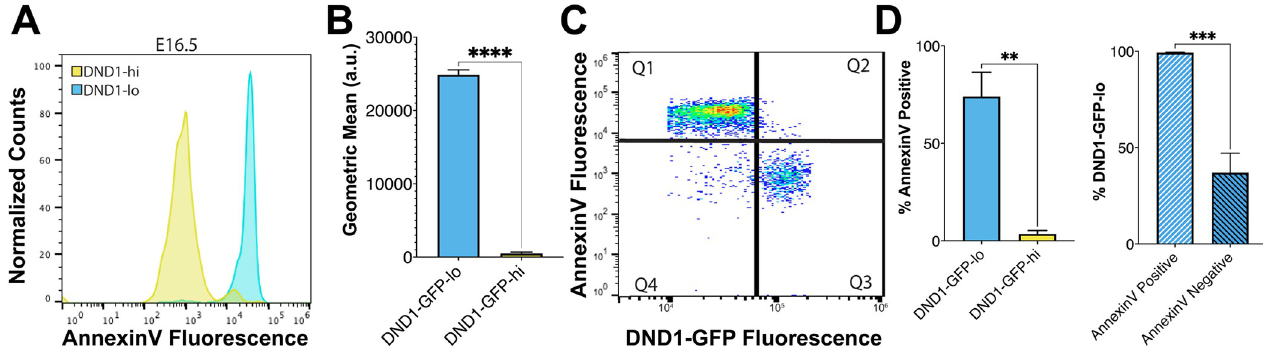
Fig 3. DND1-GFP-lo cells express more phosphatidylserine on their outer membrane, as seen through Annexin V fluorescence. A: Representative profiles of Annexin V fluorescence in E16.5 DND1-GFP-hi (yellow) and E16.5 DND1-GFP-lo (sky blue) populations. B: Geometric mean of Annexin V fluorescence in DND1-GFP-lo and DND1-GFP-hi cells. C: Representative fluorescence profile of DND1-GFP and Annexin V. Q1 (quadrant 1) = DND1-GFP-lo cells + Annexin V-positive. Q2 = DND1-GFP-hi cells + Annexin V-positive. Q3 = DND1-GFP-hi cells + Annexin V-negative. Q4 = DND1-GFP-lo cells + Annexin V-negative. D: Percent of DND1-GFP-lo cells and DND1-GFP-hi cells that are Annexin V-positive. E: Percent of total Annexin V-positive and negative cells that are DND1-GFP-lo cells. A-E: Technical replicates = 4, biological replicates > 2 fetal testes. P value: ���� < 0.0001, ��� = 0.0008, �� = 0.0014.